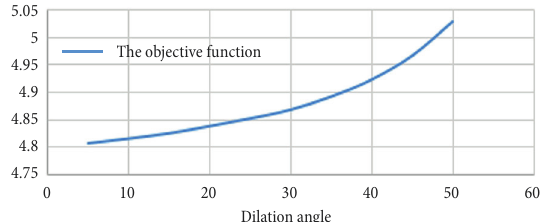
Fig. 3. The values of the objective function versus different eccentricities in uniaxial compression test